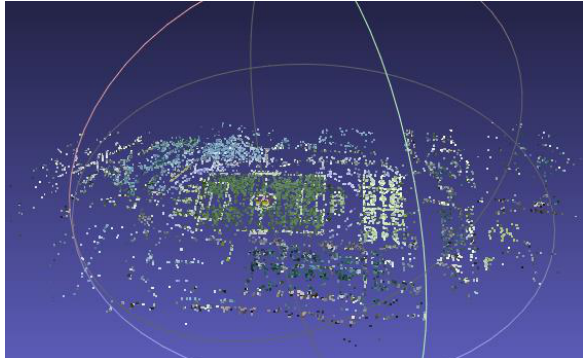
Figure 4. Initial Point Cloud after bundle